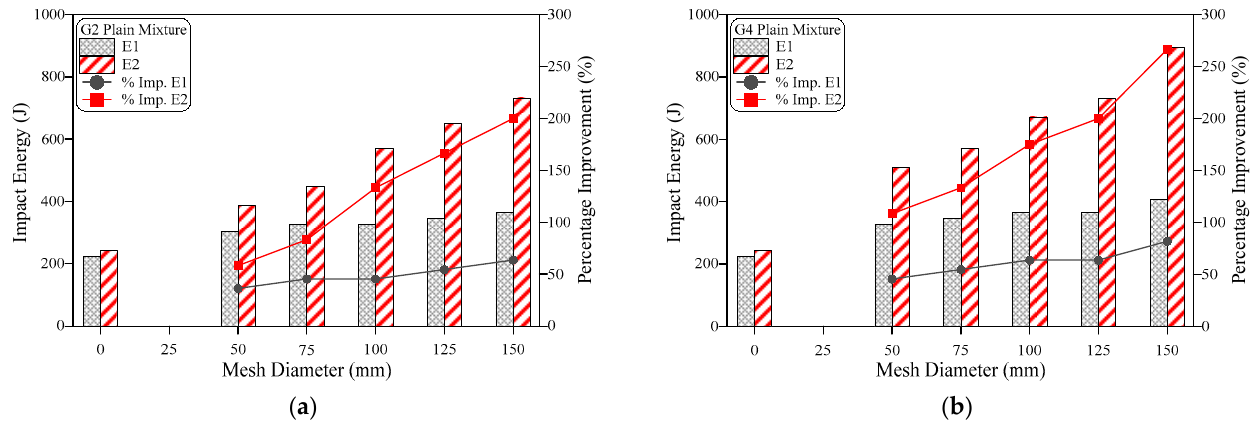
Figure 8. Effect of mesh diameter (ratio of reinforcement surface) on impact energy of plain mixtures, ( a ) 2-mesh layers, ( b ) 4-mesh layers.